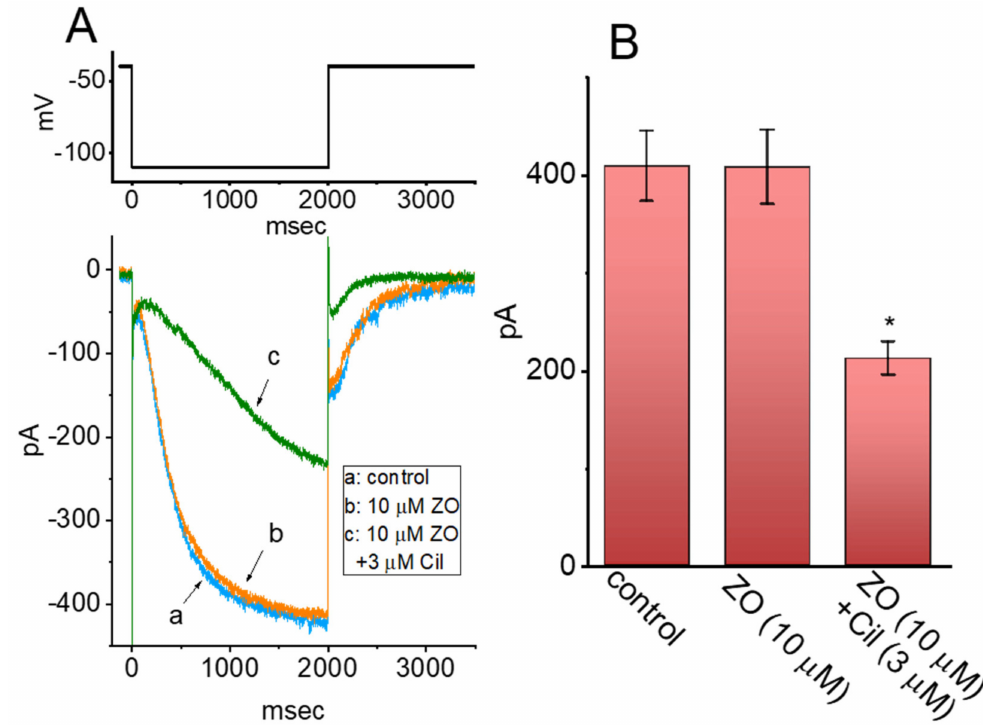
Figure 6. Inability of ZO to perturb the hyperpolarization-activated cation current ( I h ) in GH 3 cells. The experiments were conducted in cells bathed in a Ca 2+ -free Tyrode’s solution, with the internal solution backfilled with a K + -containing solution. ( A ) Representative current trace obtained in the control period (a) and cell exposure to 10 µ M ZO (b) or 10 µ M ZO plus 3 µ M cilobradine (Cil) (c). The upper part is the applied voltage-clamp protocol. ( B ) Summary bar graph showing the effects of ZO or ZO plus cilobradine (Cil) on I h amplitude (mean ± SEM; n = 7 for each bar). The current amplitude was obtained at the endpoint of a 2 s hyperpolarizing pulse ranging from − 40 to − 110 mV. * Significantly different from the control or the 10 µ M ZO-alone group ( p < 0.05). (One-way ANOVA, F(2,18) = 5.085, p =